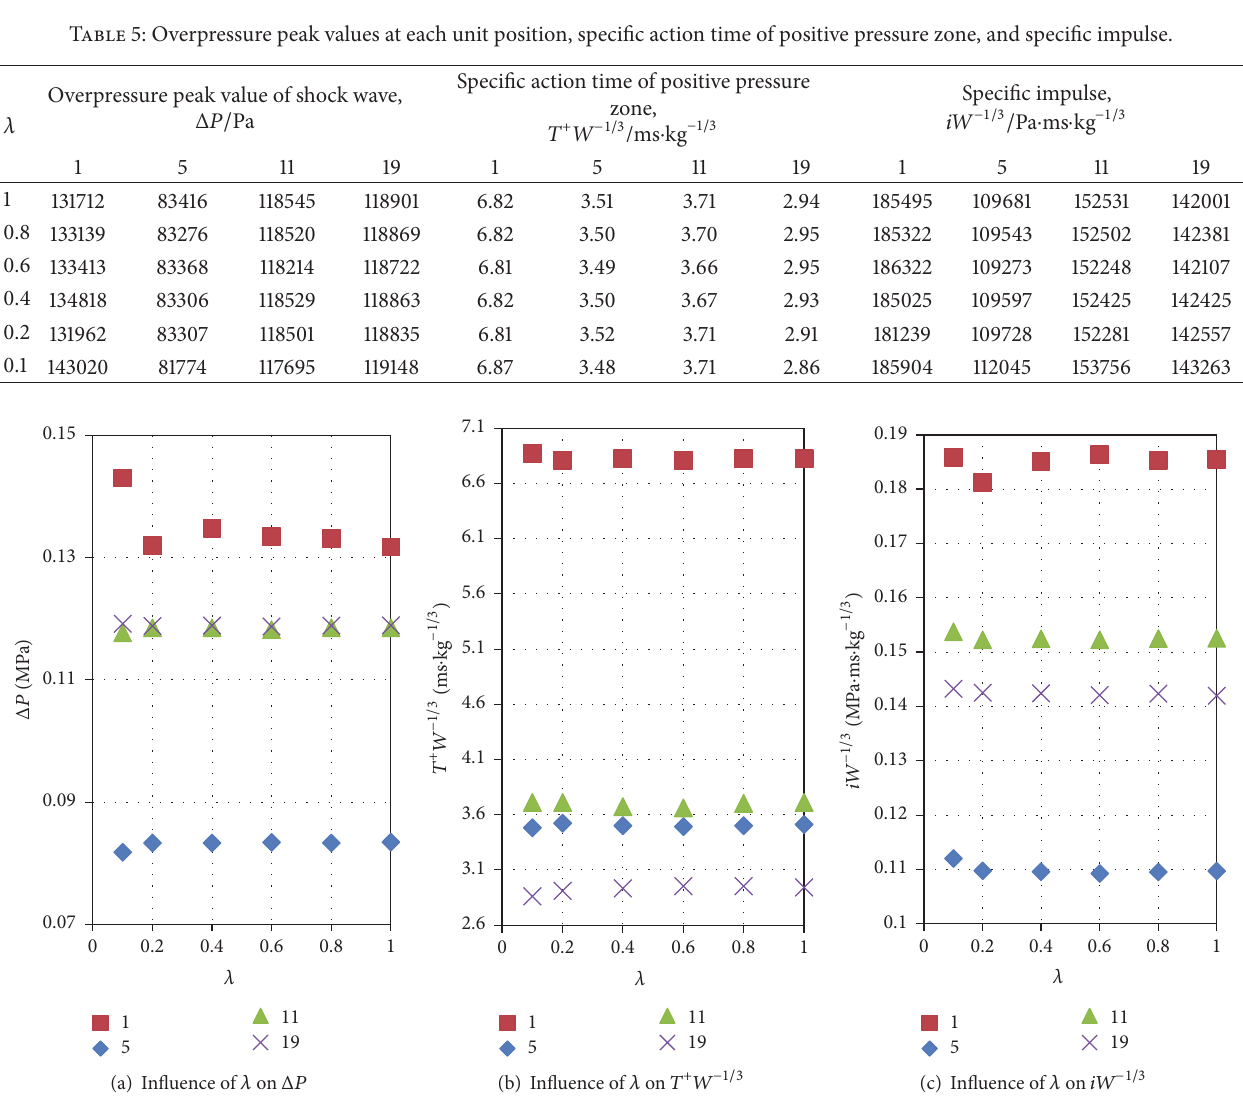
Figure 15: Relationship diagram between the scaling coefficients and the overpressure peak value of the shock wave, the specific action time of positive pressure zone, and the specific